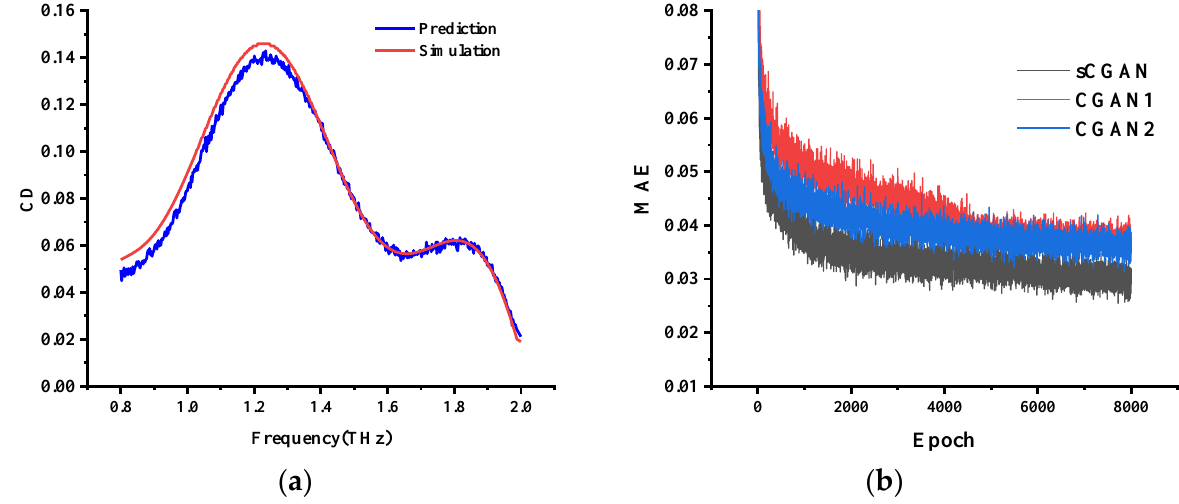
Figure 4. ( a ) Discriminator training results; ( b ) generator MAE for CGAN and sCGAN. The characteristic transmission curves of the inverse-designed structure are shown in Figure 5a. T LR is higher than the other three sets of curves at around 1.07 THz. As shown in Figure 5b, the CD at 1.07 THz has a maximum value of 0.401. Meanwhile, due to the chirality of the metasurface unit, the two structures have opposite spectra. In addition, the CD of the m-H type structure with mirror symmetry in the xoz axis reaches 0.401 at 1.07 THz. The trends of ellipticity and circular dichroism in the case of metasurface cell rotation are shown in Figure 6. It can be seen that the circular dichroism and ellipticity change as the rotation angle of the metasurface unit changes. Moreover, the trends of circular dichroism and ellipticity are positively H type